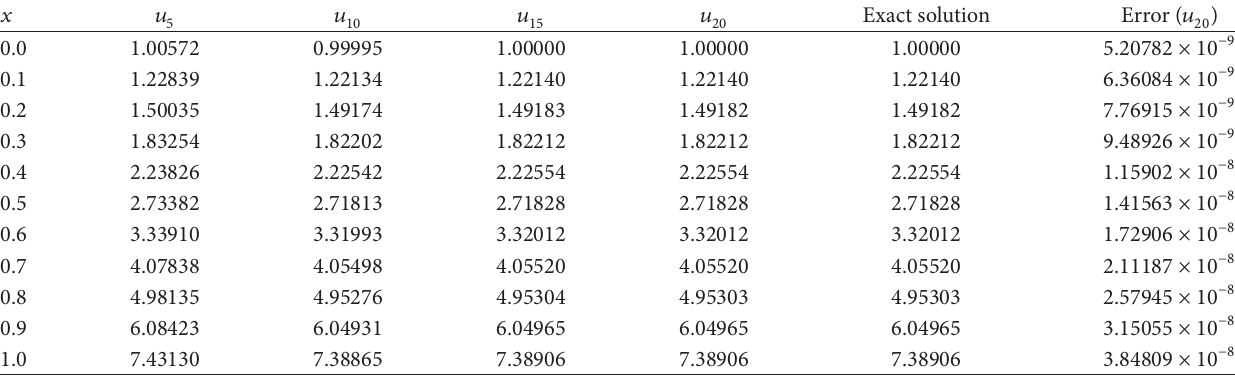
Table 1: Numerical result of Example 1.